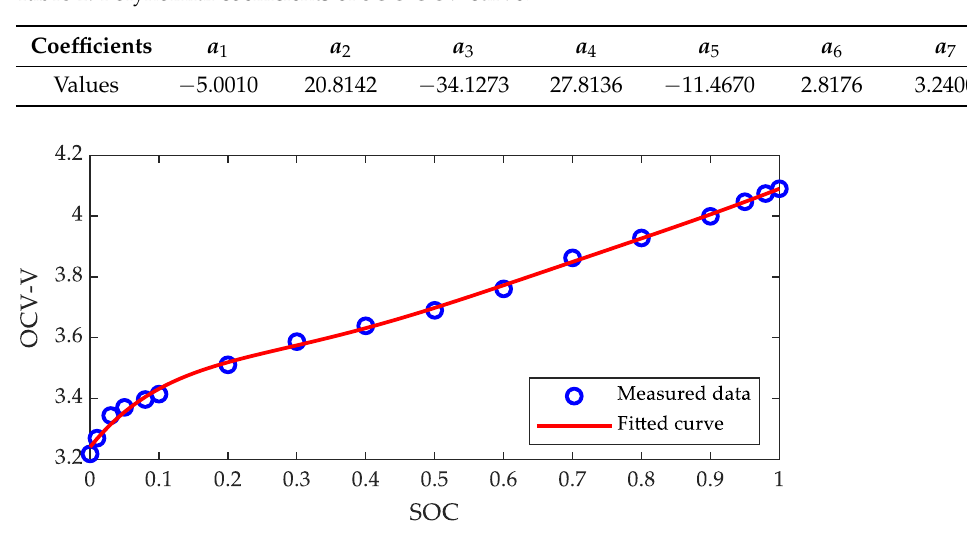
Figure 5. The measured data points and fitted curve of SOC versus OCV.